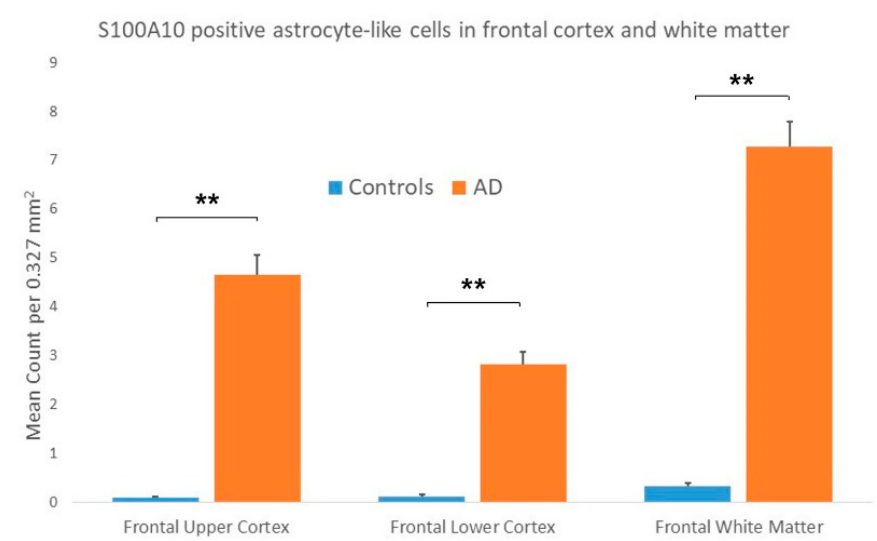
Figure 6. Results showing the mean counts of S100A10 immunopositive astrocyte-like cells (ASLCs) in the upper frontal cortex, lower frontal cortex and frontal white matter of controls and Alzheimer’s disease (AD) cases. There were significantly increased numbers of ASCLs seen in the upper frontal cortex, lower frontal cortex and frontal white matter of AD cases compared to controls. (** p < 0.001) Results are mean counts + SEM.